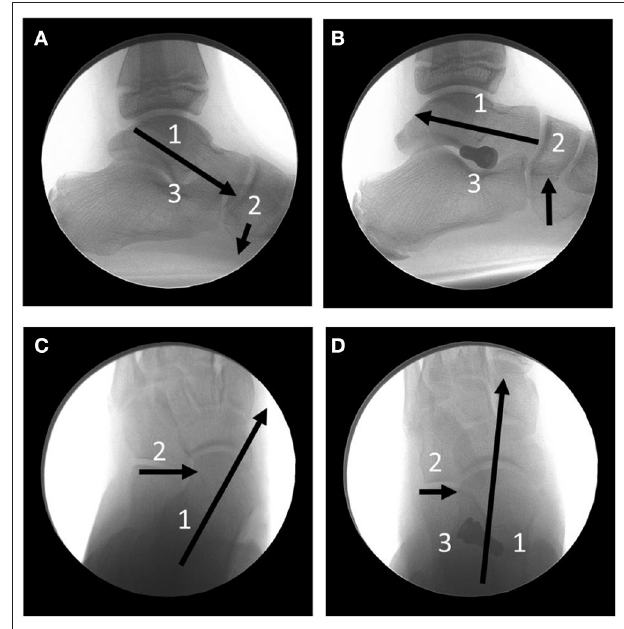
FIGURE 8 | Full Weightbearing, relaxed stance position fluoroscopic radiographs. (A) Lateral image showing the anterioplantar parital dislocation of the talus (1) on the calcaneus. The navicular (2) is forced plantarly. The sinus tarsi (3) is obliterated. (B) The same foot post-extraosseous talotarsal stabilization. Notice the realignment of the talus on the calcaneus (1) and elevated navicular (2). (3) is the HyProCure (GraMedica, Michigan, USA) sinus tarsi implant. (C) Dorsoplantar view of the hindfoot. The talus (1) is medially and anteriorly displaced on the calcaneus (2). (D) The same foot